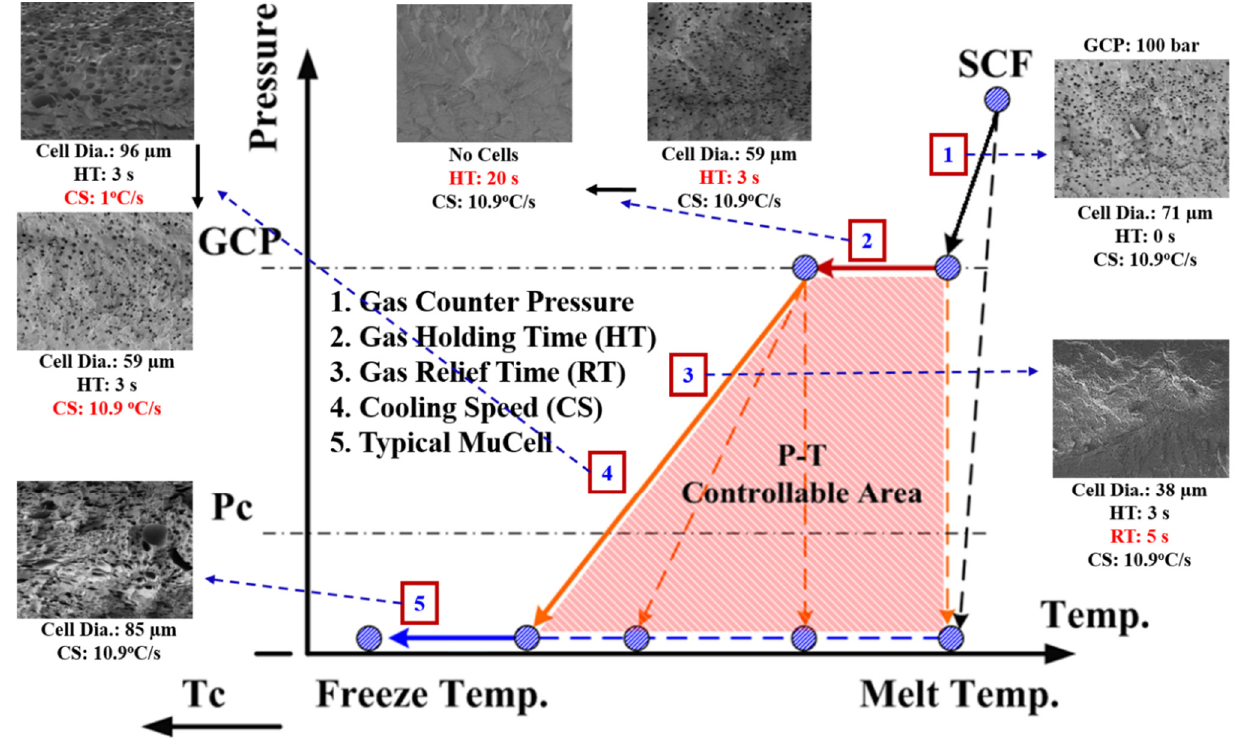
Figure 12. The representative influence of foaming morphology under various parameter combinations (i.e., different P-T paths) is illustrated.